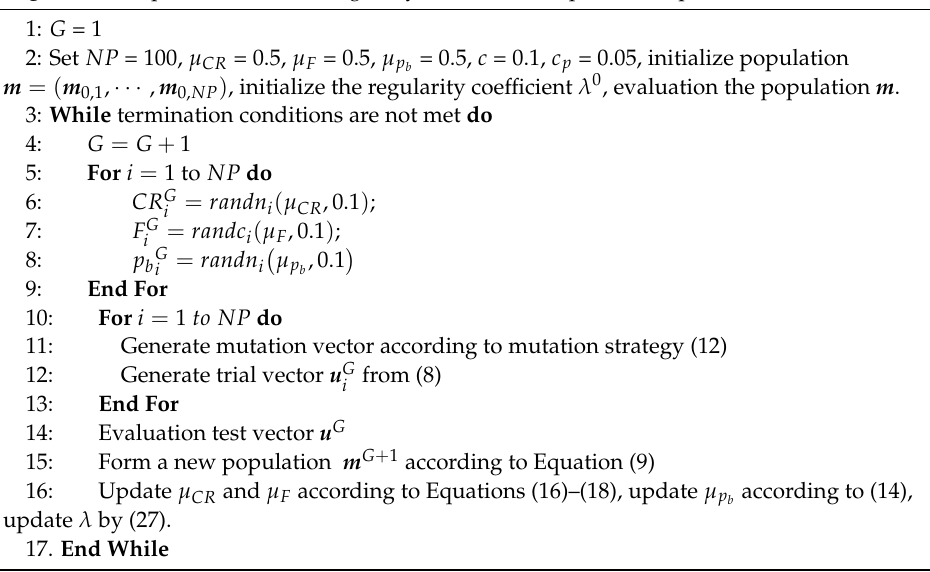
Algorithm 1. Lp-norm inversion of gravity based on an improved adaptive differential